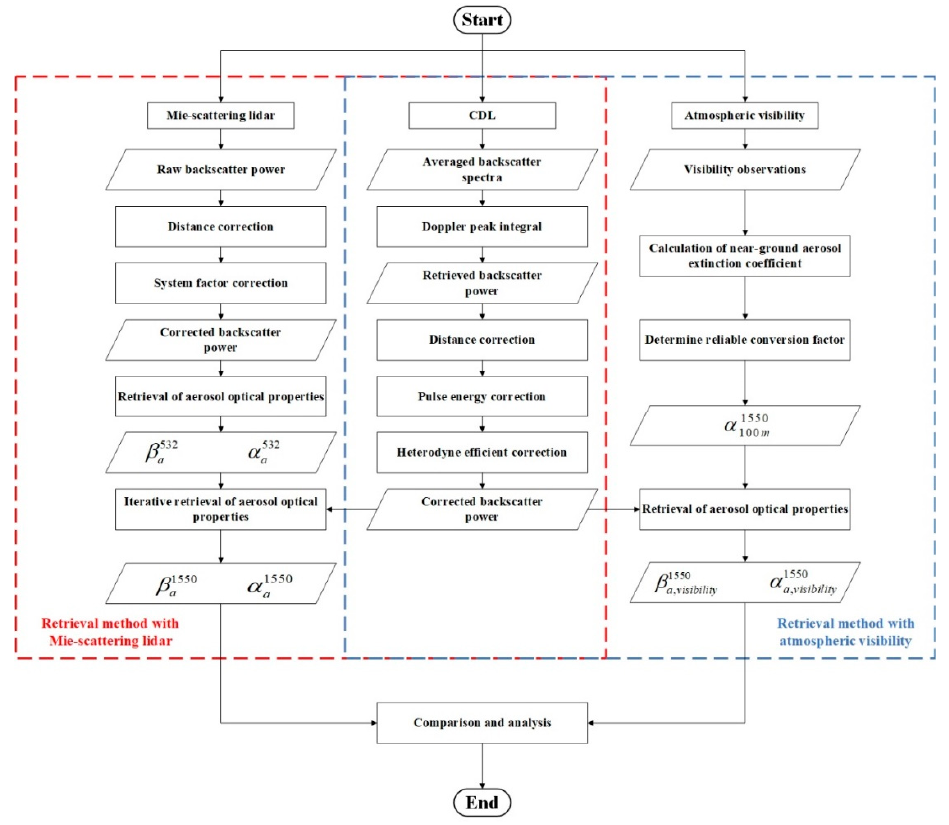
Figure 7. The flowchart shows the retrieval and verification procedures of aerosol optical properties with atmospheric